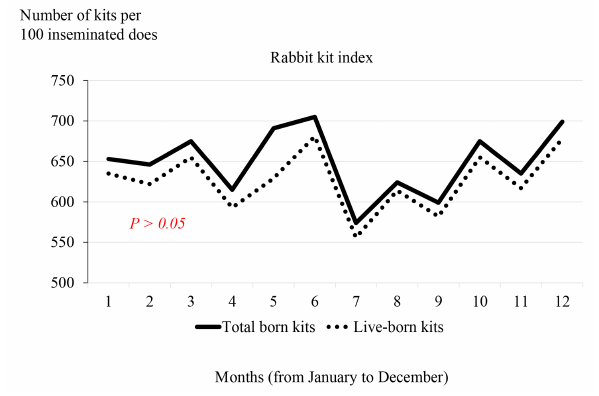
Figure 1. Kindling rate, mean litter size of live-born kits, and the kit index (KI) with respect to the season of the year. Figure 2. The rabbit kit index of total born kits and live-born kits with respect to month of the